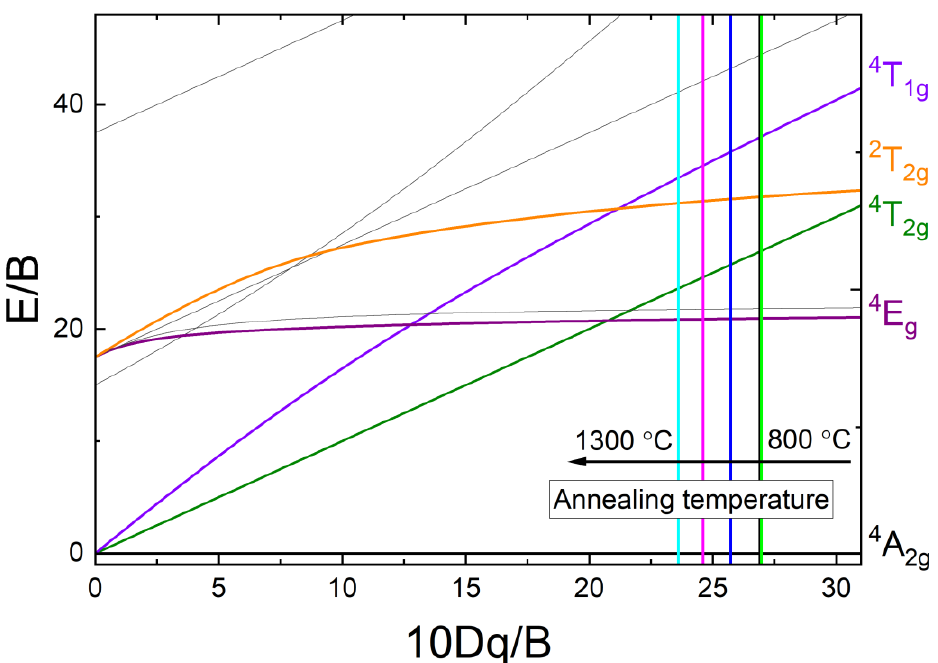
Figure 5. d 3 Tanabe – Sugano diagram for Cr 3+ ion in an octahedral environment. Vertical solid lines indicate the calculated values of 10Dq/B parameter for samples annealed at different temperatures. The line colors correspond to the colors of the plotted PLE spectra.